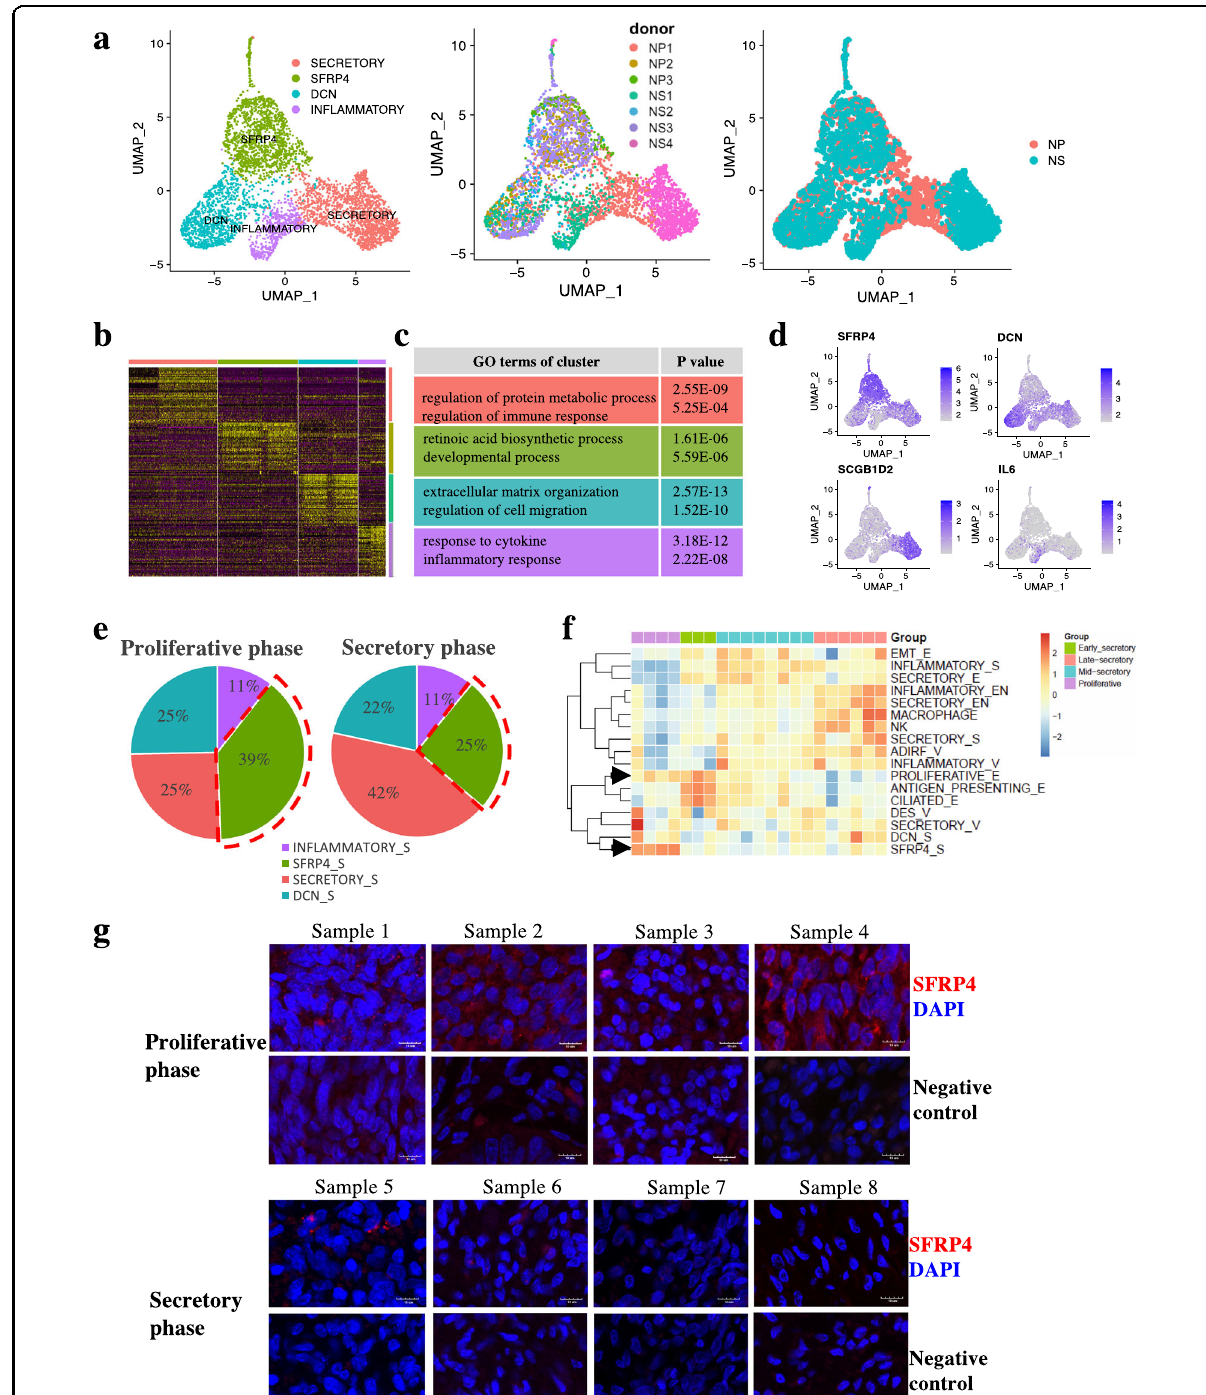
Fig. 2 Cell population architectures across the menstrual cycle identi fi ed SFRP4 + stroma cells as potential regenerative endometrial cell populations. a UMAP plot of four uterus stroma cell sub-populations, donor ID and secretory/proliferative origin phases using Seurat. b Heatmap shows differential expressed gene signature of each sub-cluster from stromal cells. c Gene ontology (GO) analysis of the speci fi cally expressed gene signature of each sub-population from stroma cells. d Featureplot depicted speci fi c markers for each stroma sub-population ( SCGB1D2 for secretory stroma cells; SFRP4 for SFRP4 + stroma cells; DCN for DCN + stroma cells; IL6 for in fl ammatory stroma cells). e Cell proportions of endometrial stromal in the proliferative and secretory phase of the endometria. f Heatmap showed relative proportional score of each subpopulation in endometria during the menstrual cycle from proliferative, early-secretory, mid-secretory to late-secretory phase of human endometria, the black arrow highlighted the proliferative epithelia and SFRP4 + stroma with high relative proportional score in proliferative phase. g Immuno fl uorescence staining of SFRP4 + stroma in different phase of menstrual cycle. Scale bar, 10